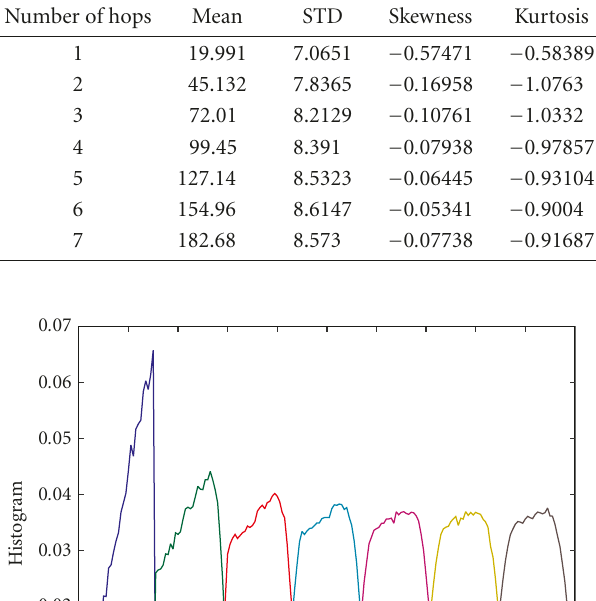
Table 1: Statistics of f ( r | H i ).